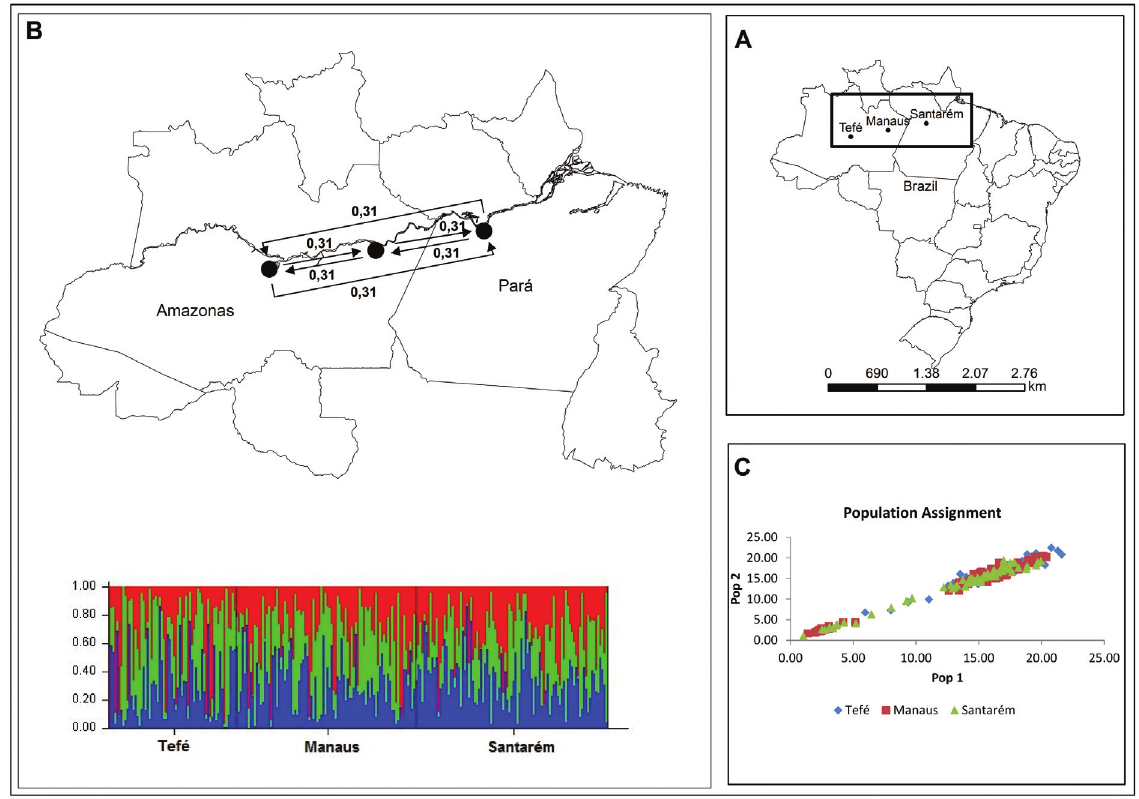
Figure 1 - Populations of Colossoma macropomum in the Amazon studied. (A) Map illustrating the localization of Colossoma macropomum populations intheAmazonbasin.(B)Nonsignificantasymmetryofmigrationratesatk=3,arrowsindicatedirectionandrateofrecentmigrationrates;estimateswere obtained with BIMr and Bar plots from Structure (below) without clustering of the data (C) Population assignment test done in GenAlEx to determine the likelihood of inclusion of the individuals in each